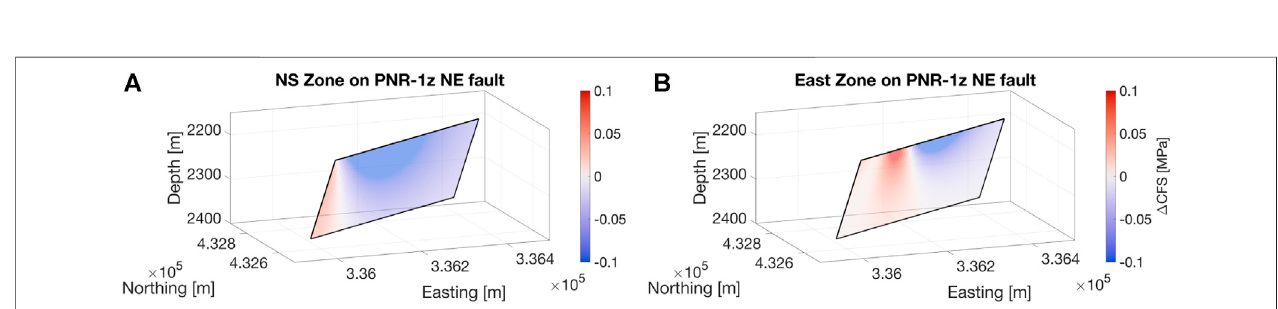
FIGURE 8 | Δ CFS values on the PNR-1z NEF plane (as de fi ned by the largest induced events and seismic activity, see Clarke et al., 2019a) produced by the NS Zone of hydraulic fracturing (A) and the Eastern Zone (B) .